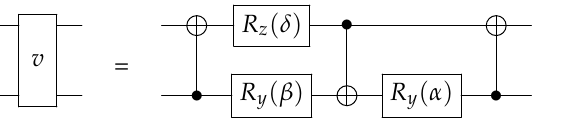
Figure 7. The circuit v used to construct a universal two-qubit gate